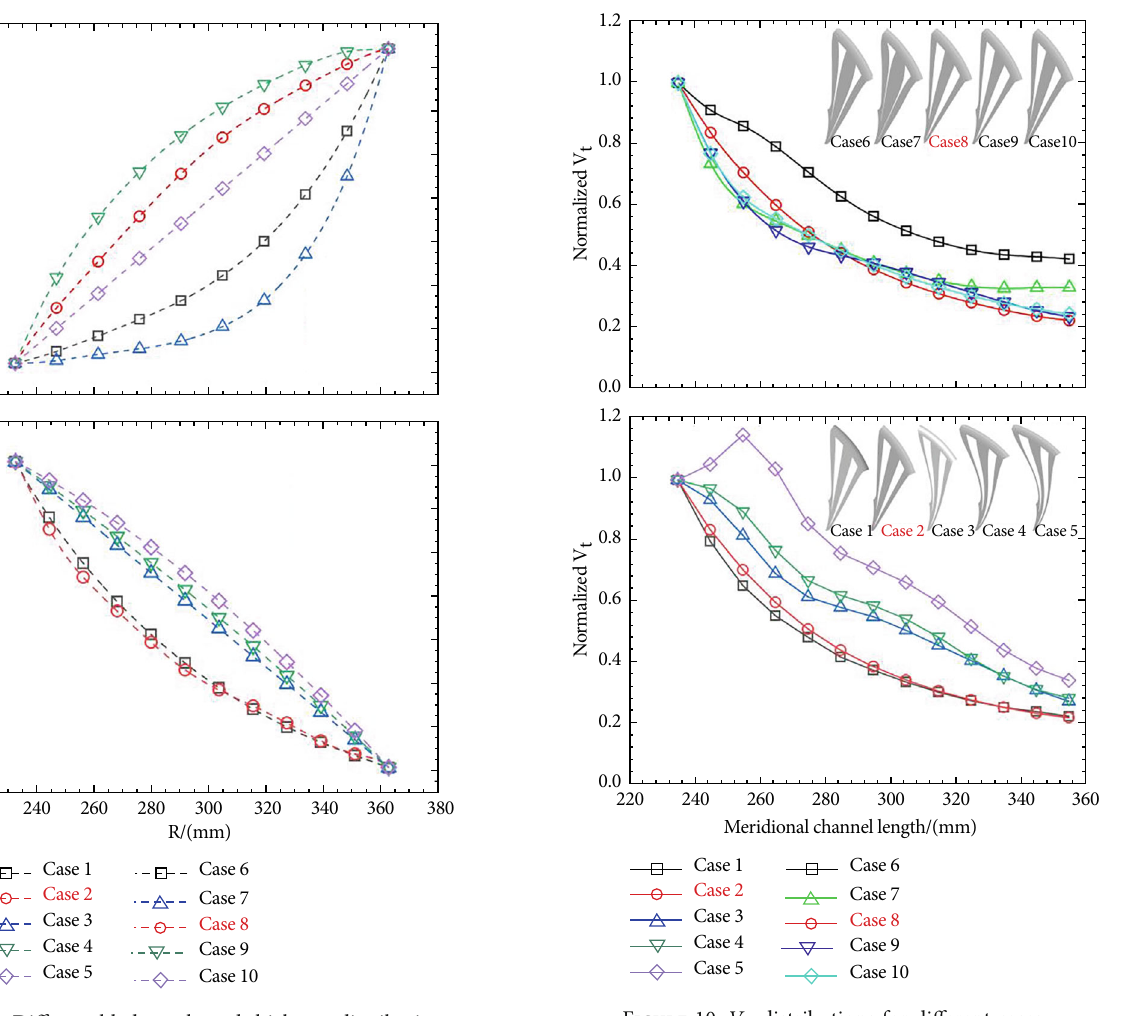
Figure 9: Di ff erent blade angle and thickness distributions. Table 5: Performance comparisons for di ff users with di ff erent blade angle distributions.